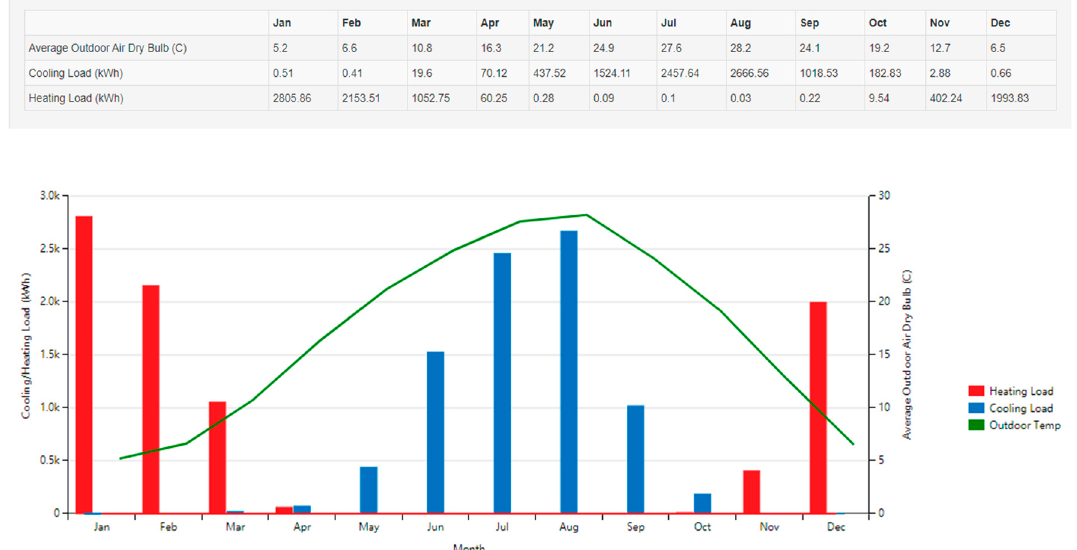
Figure 7. Monthly cooling load and heating load (kWh), as well as the monthly average outdoor temperature (°C).